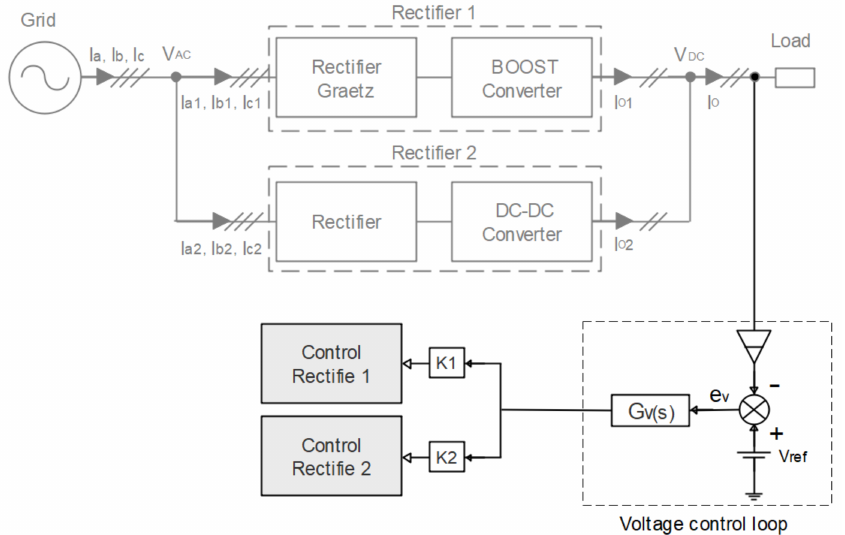
Figure 11. Representation of the second mode for power distribution in the HTR using the K1 and K2